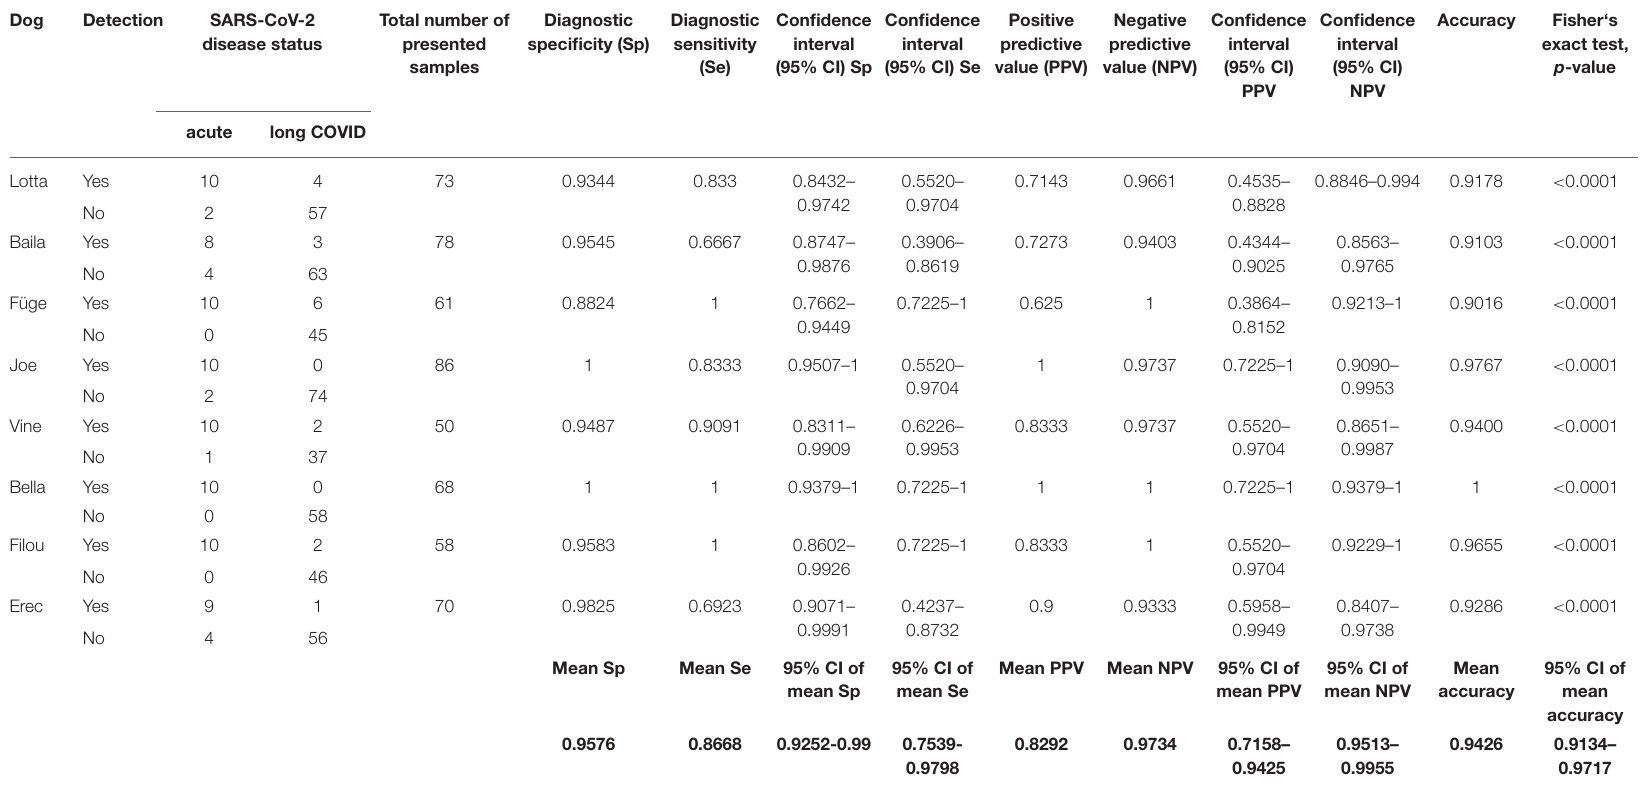
TABLE 1 | Diagnostic performance of the scent detection dogs in test scenario I (Acute COVID-19 vs. Long COVID). Dog